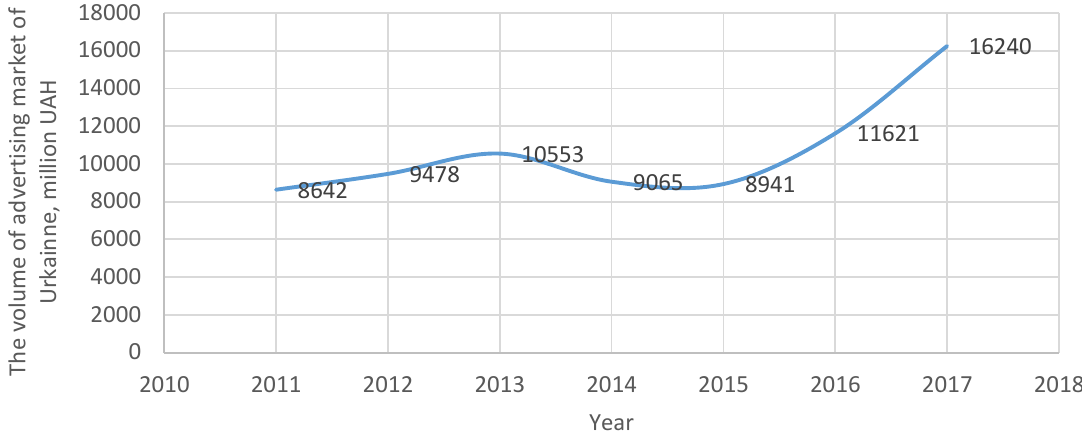
Figure 3. The tendencies of change of volume of the advertising market of Ukraine during the period